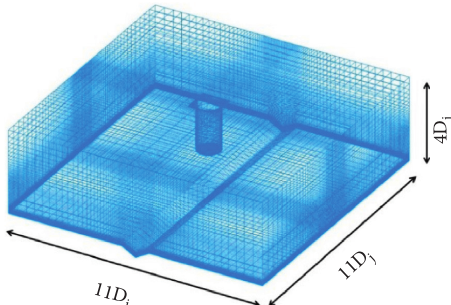
Figure 4: Overall mesh for the gorge terrain.